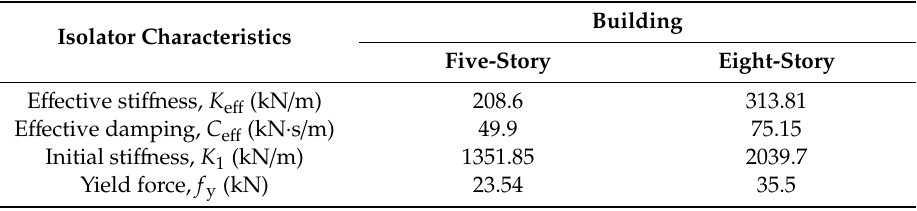
Table 1. Parameters of the seismically isolated structural models.